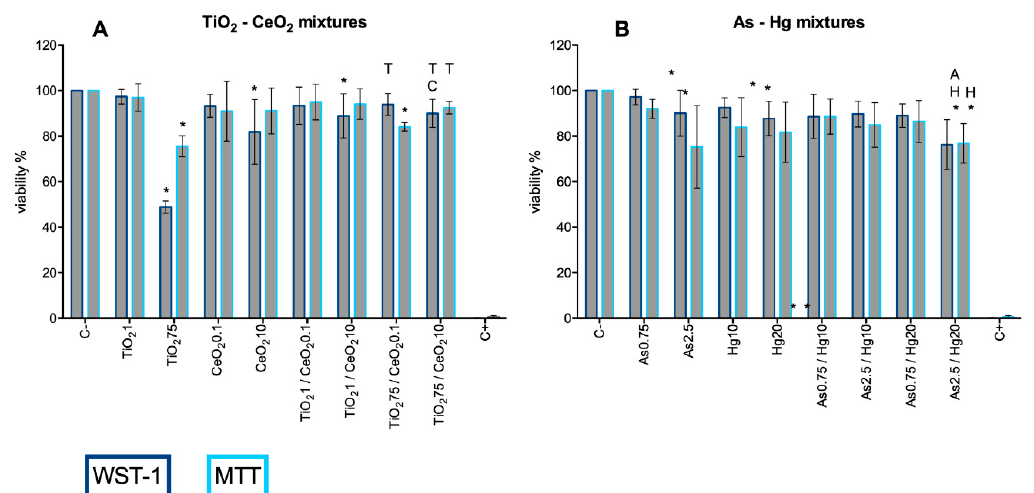
Figure 9. Viability of A549 cells 24 h post ‐ exposure to binary mixtures of TiO 2 ‐ CeO 2 nanoparticles ( A ) and As ‐ Hg ( B ) assessed by WST ‐ 1 (dark blue bars) and MTT (light blue bars) assays, compared to single exposure (left bars). All concentrations expressed in mg/L with the exception of CeO 2 NP which is expressed in μ g/L. C − : negative control; C+: positive control (Triton X ‐ 100 1%). Values are expressed as mean ± standard deviation (n ≥ 3, each experiment in triplicate). Statistical significance of samples compared to C − is indicated by *; also indicated is statistical difference compared to Titanium T; Cerium C; Arsenic A; and Mercury H (One ‐ way ANOVA; p ≤ 0.05).